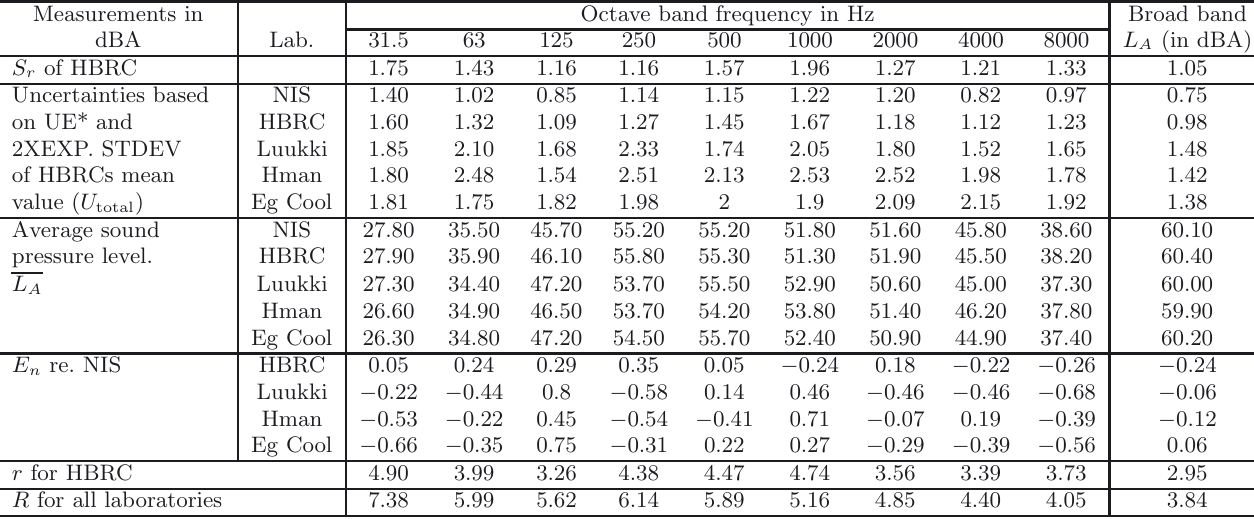
Fig. 1. (Color online) Expanded uncertainty contributions in L A results at 125 Hz. Table 4. Inter-Laboratory comparisons results indoor sound pressure level measurements of